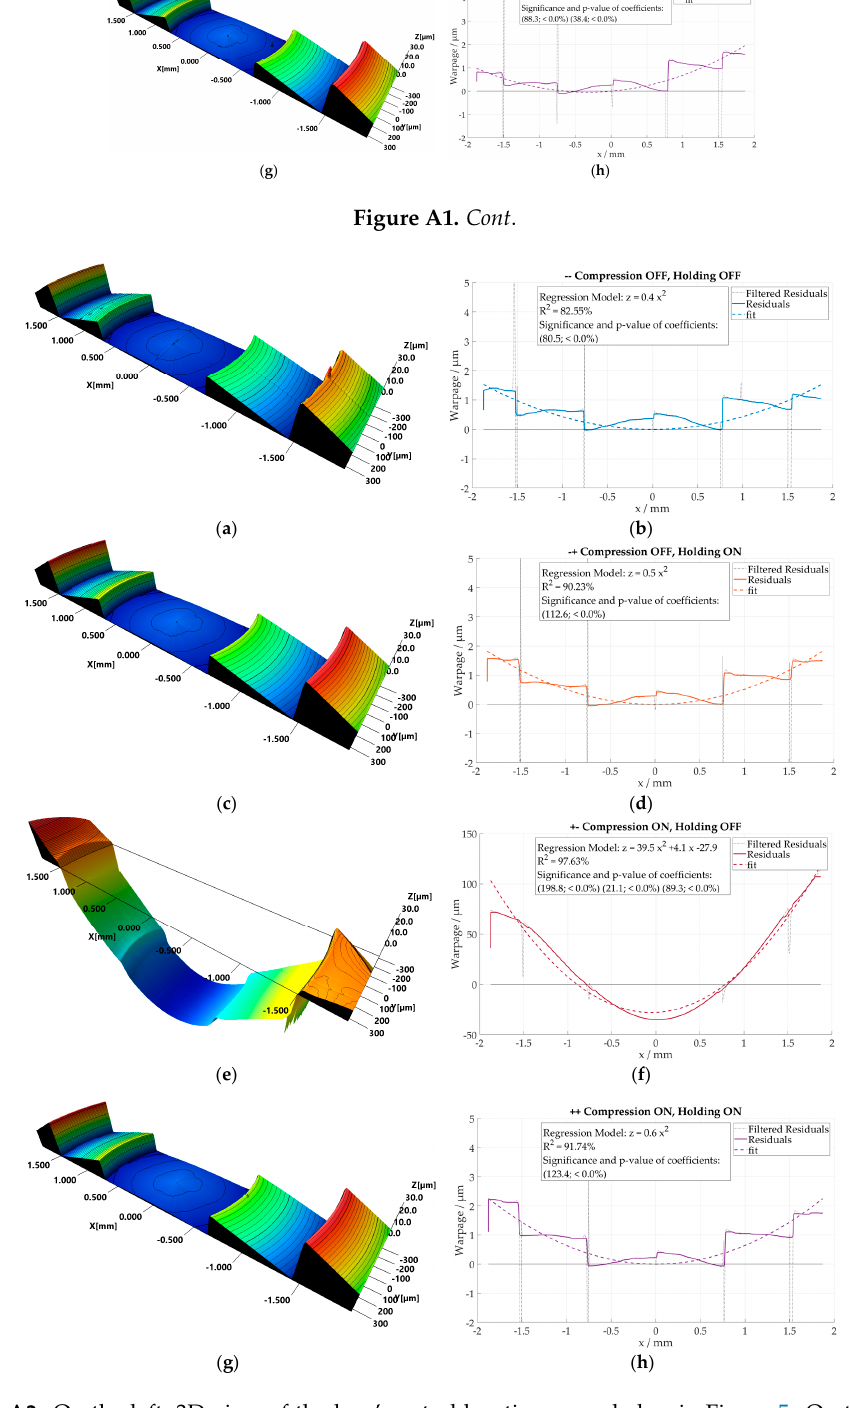
Figure A2. On the left, 3D view of the lens’ central location, sampled as in Figure 5. On the right, the residuals of the respective x profiles, in comparison with nominal geometry sampled in the image center. The following process conditions are considered for PMMA material results: ( a , b ) IM without holding; ( c , d ) IM; ( e , f ) ICM without holding; ( g , h ) ICM.